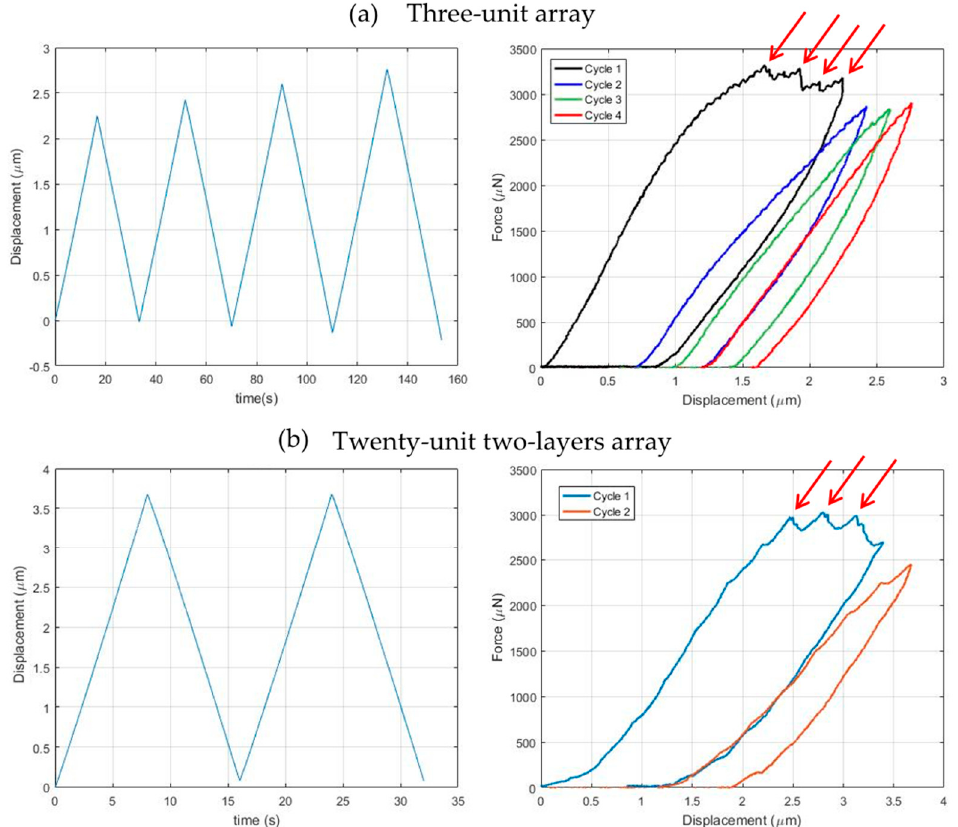
Figure 9. Mechanical responses revealing microcrack and fracture. ( a ) Imposed displacement-time and force-displacement plots for a three-unit array (cf. Video S5: Three-unit cracking). ( b ) Imposed displacement-time and force-displacement plots for a twenty-unit two-layer array (cf. Video S6: Twenty-unit two-layer cracking). Arrows indicate fracture events during the deformation.